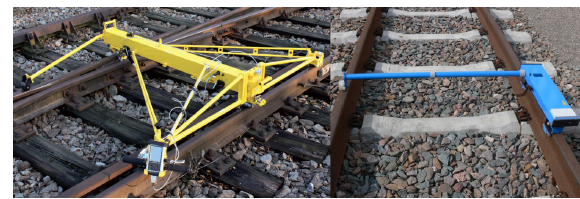
Figure 3. Trolley Krab (track geometry) [5] and Salamander